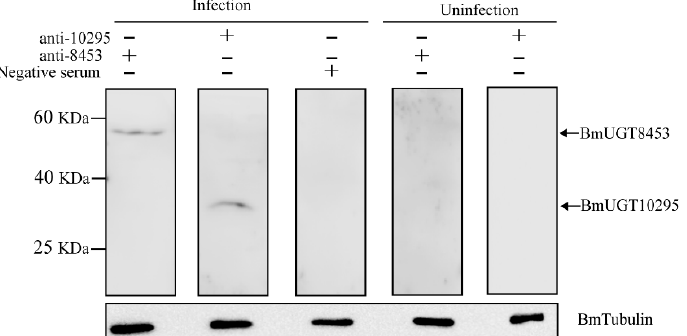
Figure 4. Western blotting analysis of BmUGT expression in infected silkworms. The polyclonal antibodies of BmUGT10295 (anti-10295) and BmUGT8453 (anti-8453) recognized the corresponding signal in infected silkworms, but not in uninfected silkworms. BmTubulin was used as an internal reference.